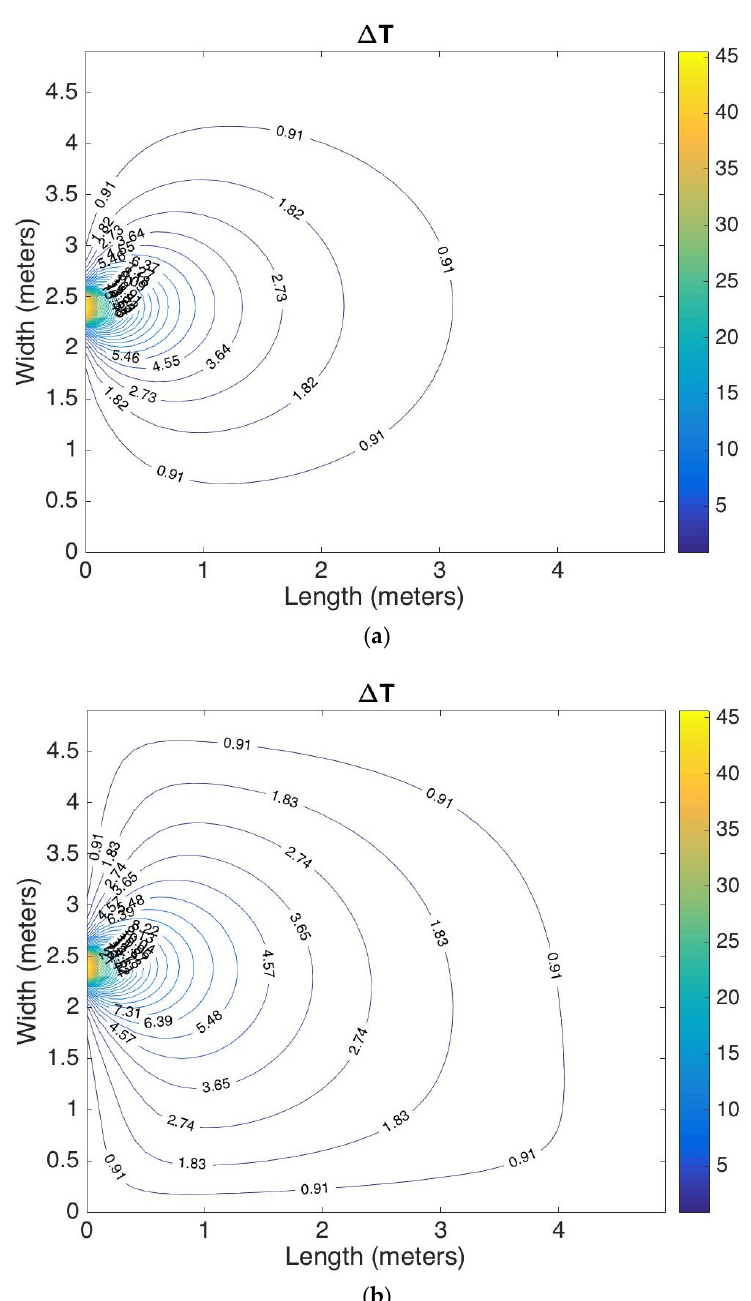
Figure 4. Temperature difference, ∆ T = T − T 0 , contours of Case 1 with ( a ) Br = 0.0 and ( b ) Br =